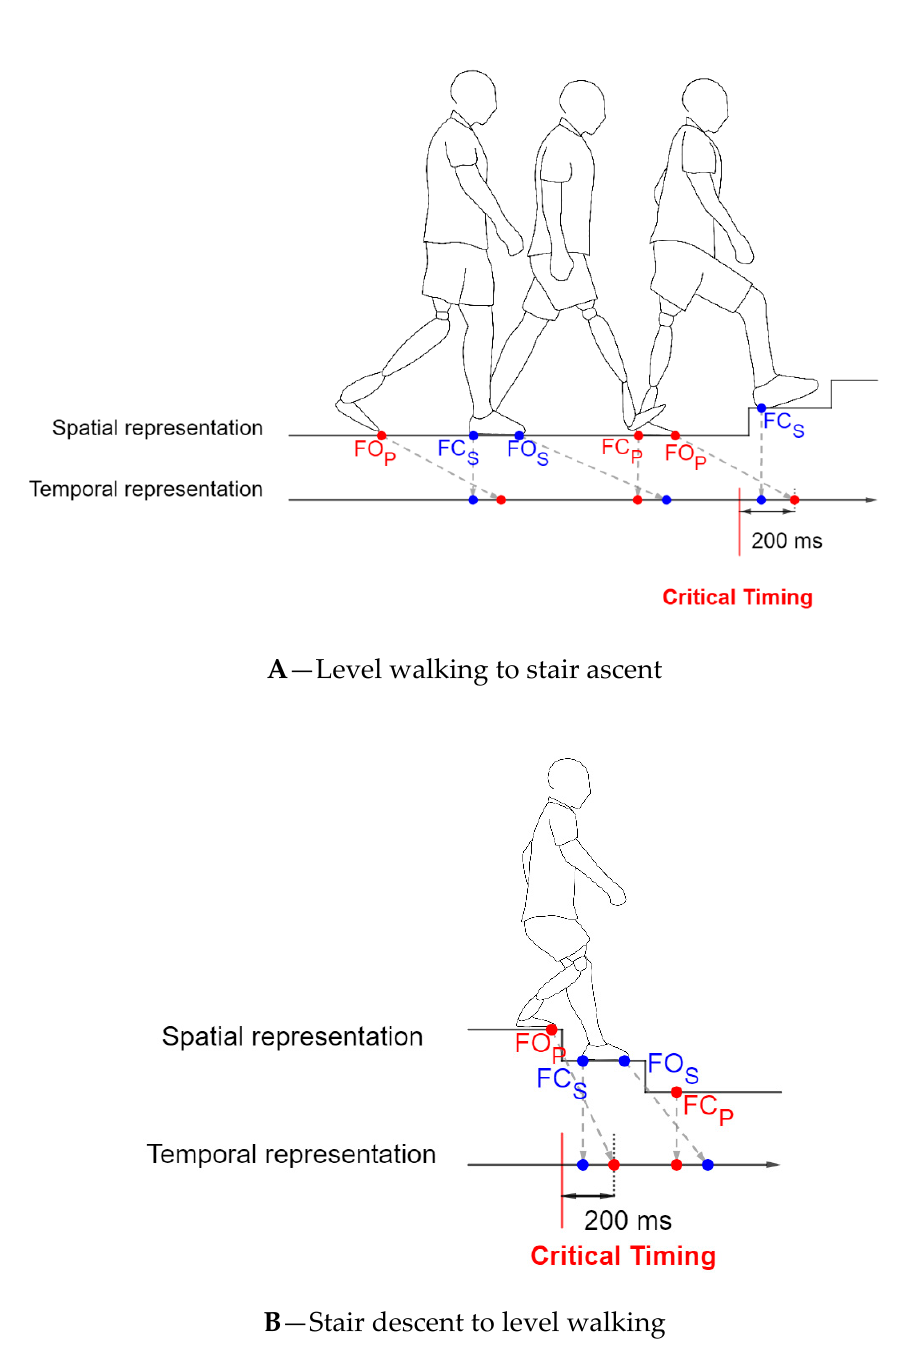
Figure 2. Example of the critical timings used in Huang et al. [23].